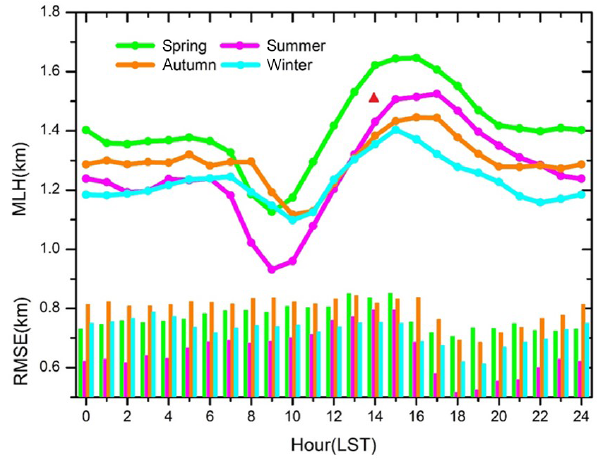
Figure 8. Seasonal variation of the diurnal cycles of MLH L re- trieved from lidar (dot lines) and the standard deviation of MLH L (histograms). The red triangle indicates the MLH RS measured at 14:00LST by